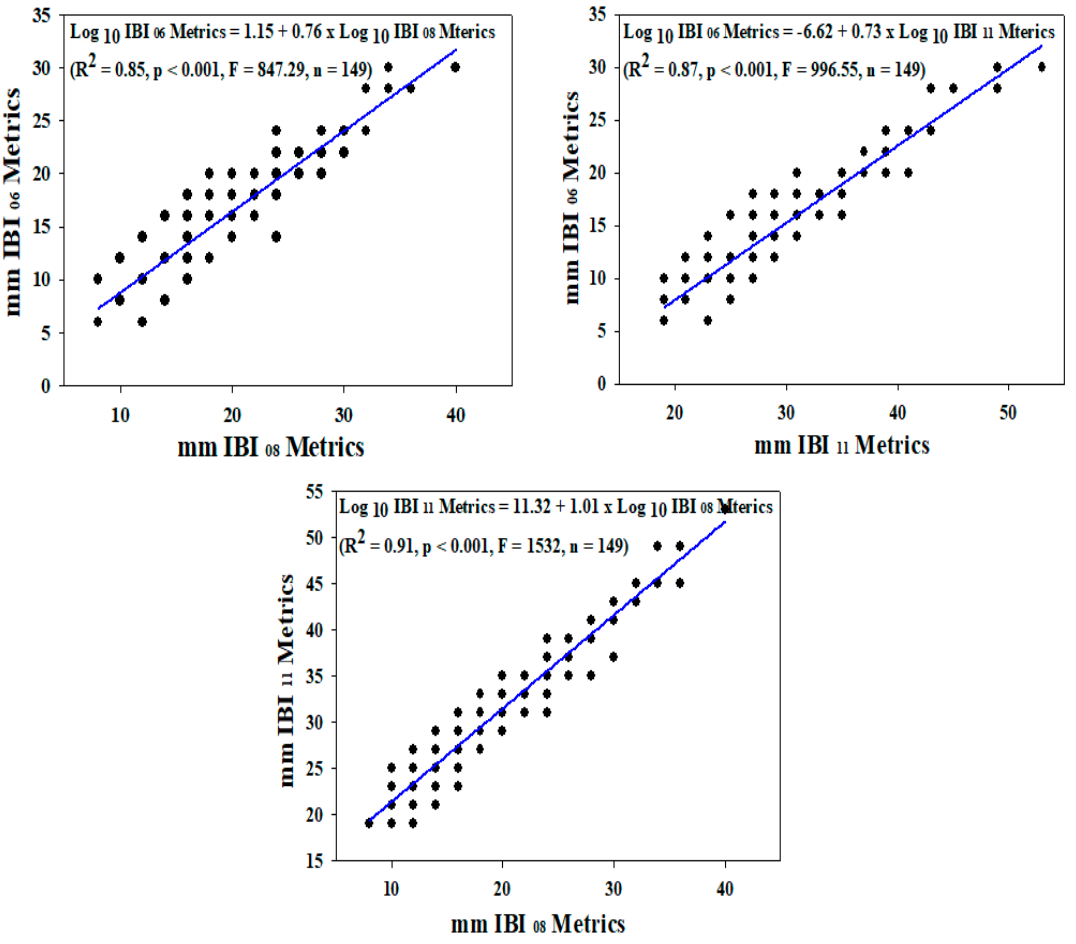
Figure 3. Regression analyses on the mmIBI models in Geum River watershed.